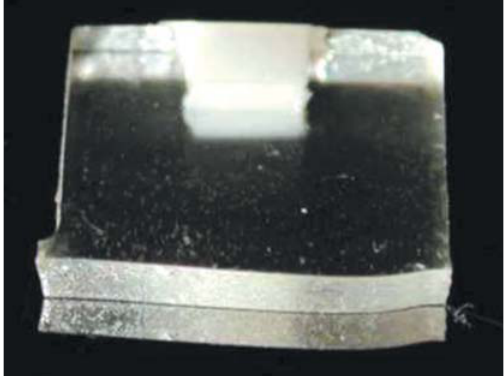
FIGURE 2- Cross-sectioned specimens for photoelastic analysis